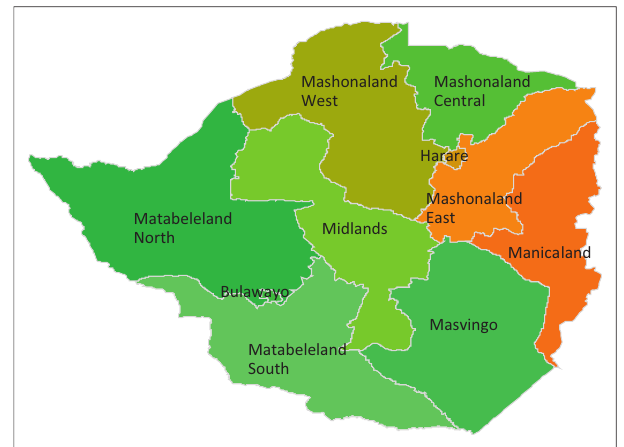
FIGURE 2: A map of Zimbabwe and its